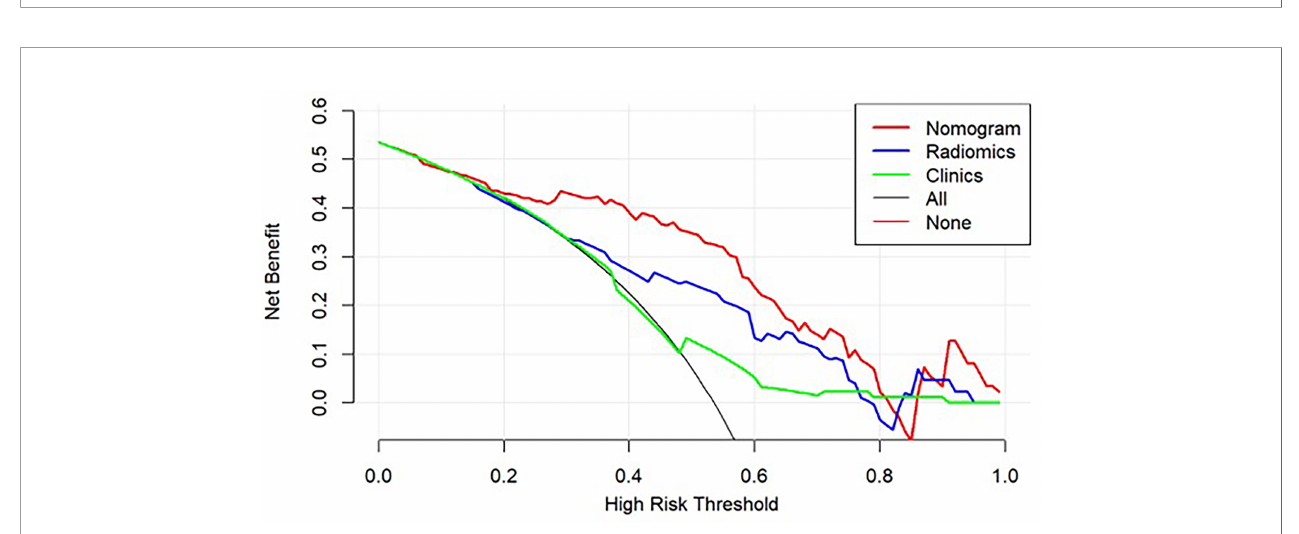
FIGURE 5 | Decision curve analysis for the models built with the nomogram (red), radiomic model (Radiomics, blue), clinical model (Clinics, green), and a combination of all models (Nomogram, Red). The y-axis measures the net bene fi